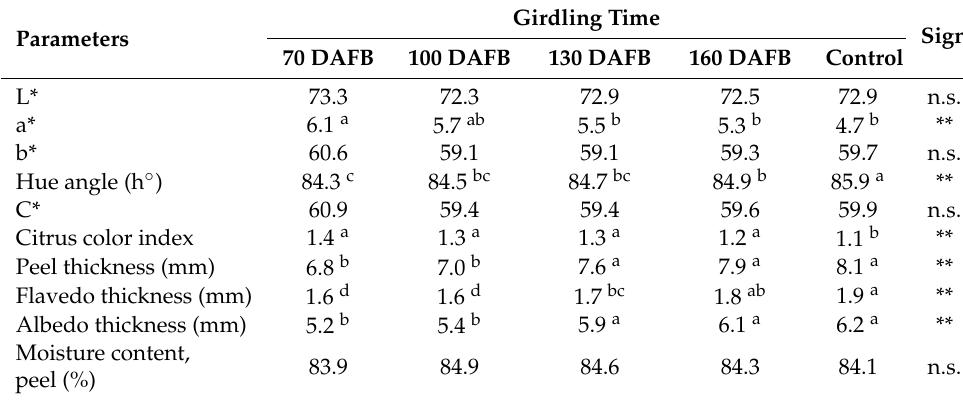
Table 2. Effects of girdling time on the main peel characteristics. Parameters